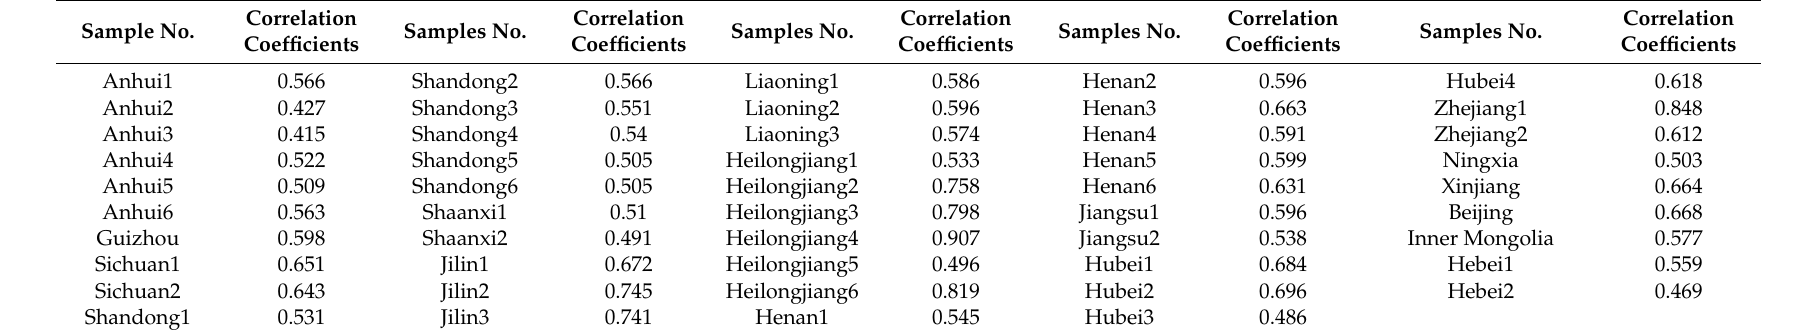
Table 3. The Correlation coefficients between 49 Chinese and reference chromatogram of CBM